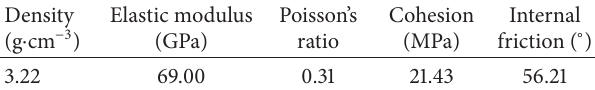
Figure 1: LSDYNA model. Table 1: Parameters of the rock material.